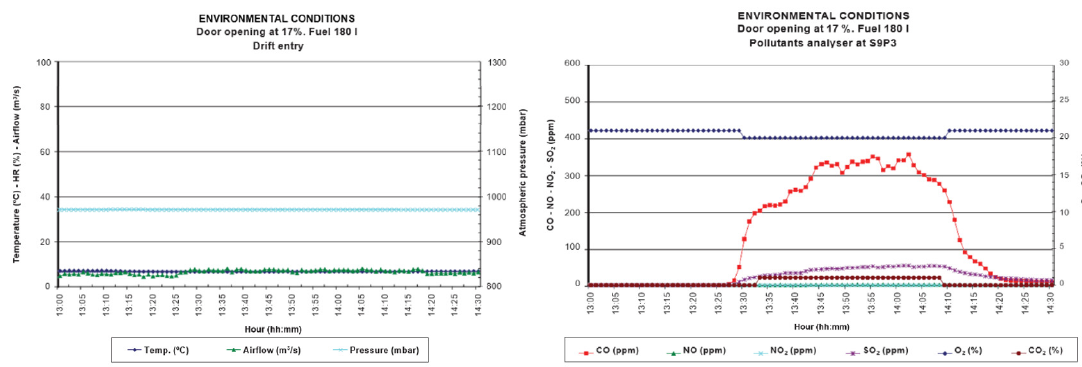
Figure 6. Evolution of the environmental conditions over time; test 2.